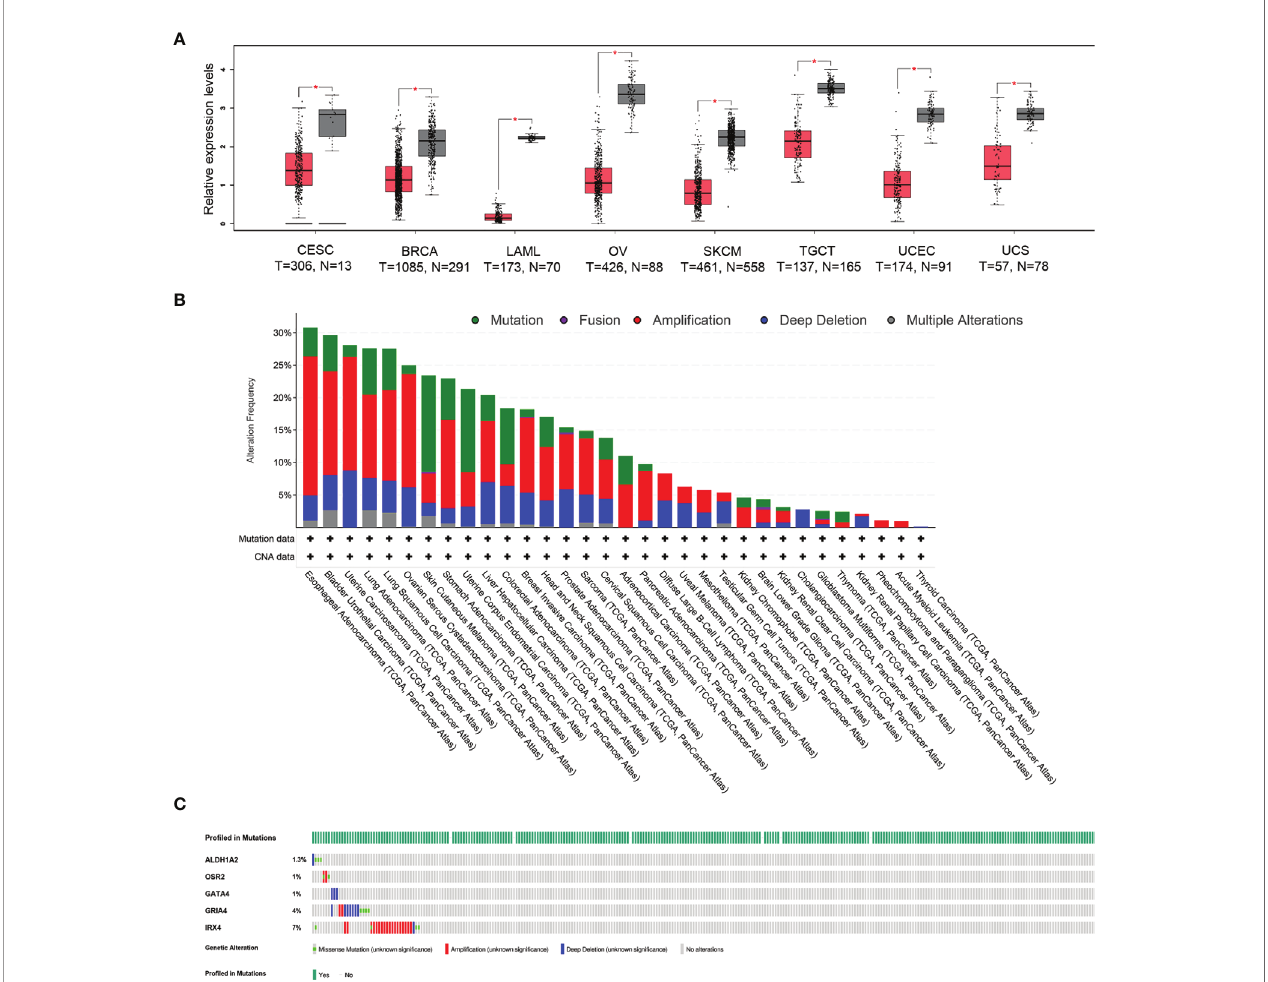
FIGURE 1 | Different expression and mutational landscape of HPV-related gene signature in multiple TCGA-cohorts. (A) The signi fi cantly different expression pro fi le of HPV- related gene signature between tumor and normal tissues (GTEx database) was identi fi ed in eight TCGA-cohorts, including Cervical squamous cell carcinoma and endocervical adenocarcinoma (CESC), Breast invasive carcinoma (BRCA), Acute Myeloid Leukemia (LAML), Ovarian serous cystadenocarcinoma (OV), Skin Cutaneous Melanoma (SKCM), Testicular Germ Cell Tumors (TGCT), Uterine Corpus Endometrial Carcinoma (UCEC), Uterine Carcinosarcoma (UCS), * P < 0.05. (B) Genetic alterations of HPV-related gene signature from 32 TCGA-cohorts were presented. (C) Oncoprint shows genetic alterations of the fi ve-gene signature in the cohort of